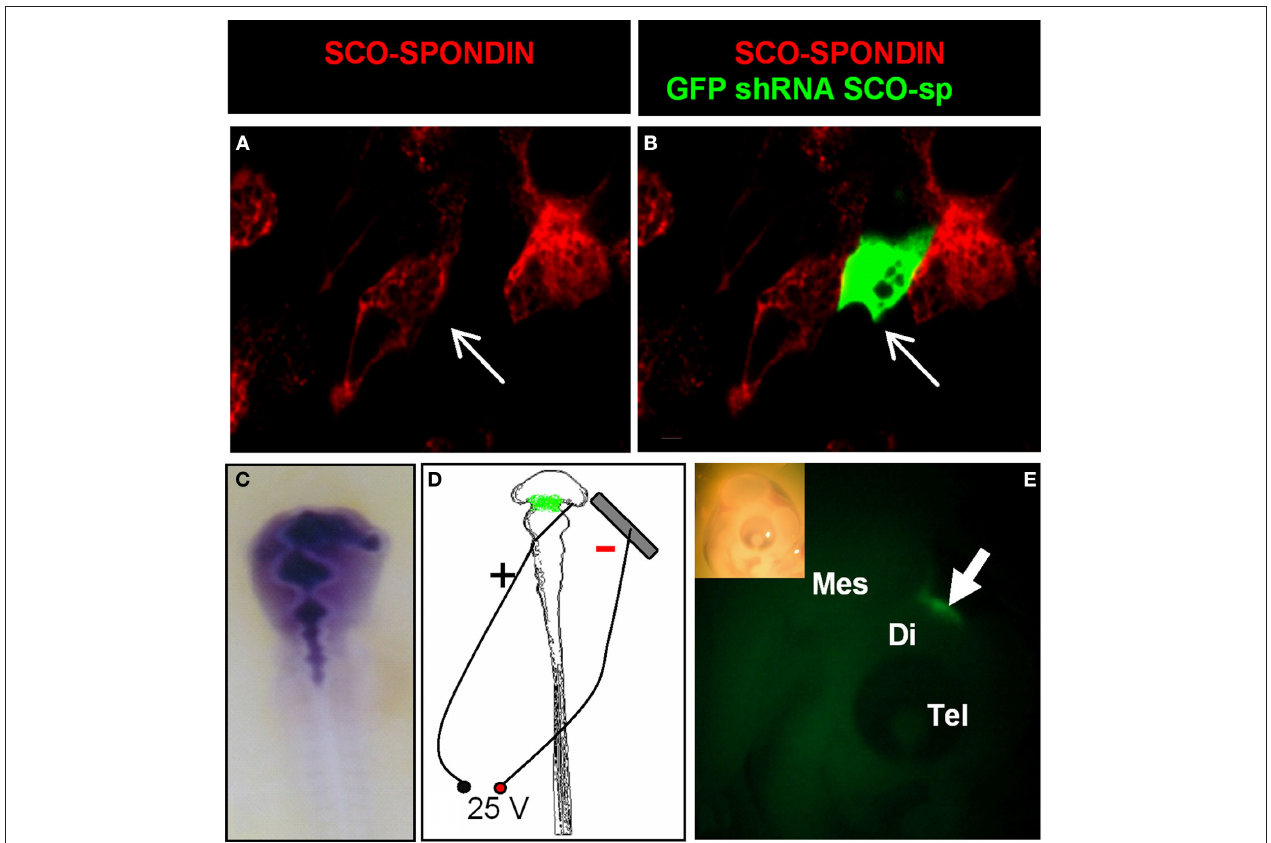
Green into the neural tube at HH11. (D) Schematic drawing showing the respective position of the positive electrode on the dorsal diencephalic region and negative electrode below the embryo. (E) Lateral view of a chick embryo head 24h post-electroporation (inset) showing GFP expression at the level of the dorsal diencephalic- mesencephalic boundary (arrow in E